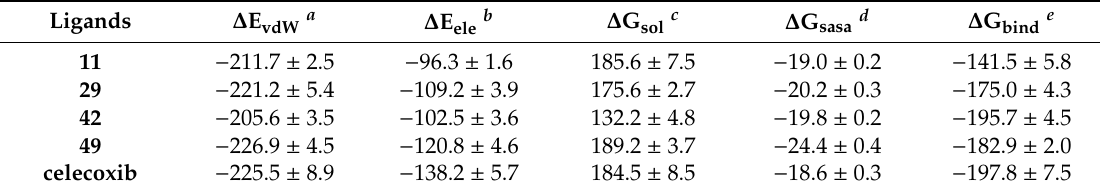
Table 3. Binding-free and related energies calculated using molecular mechanic / Poisson Boltzmann surface area (MM / PBSA) method for test